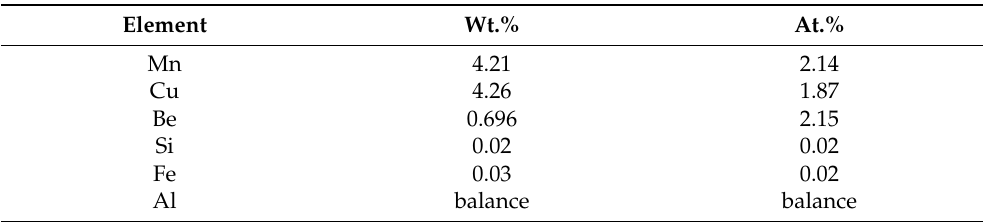
Table 1. The chemical composition of the investigated alloy as determined using AES-ICP (atomic emission spectroscopy–inductively coupled plasma).